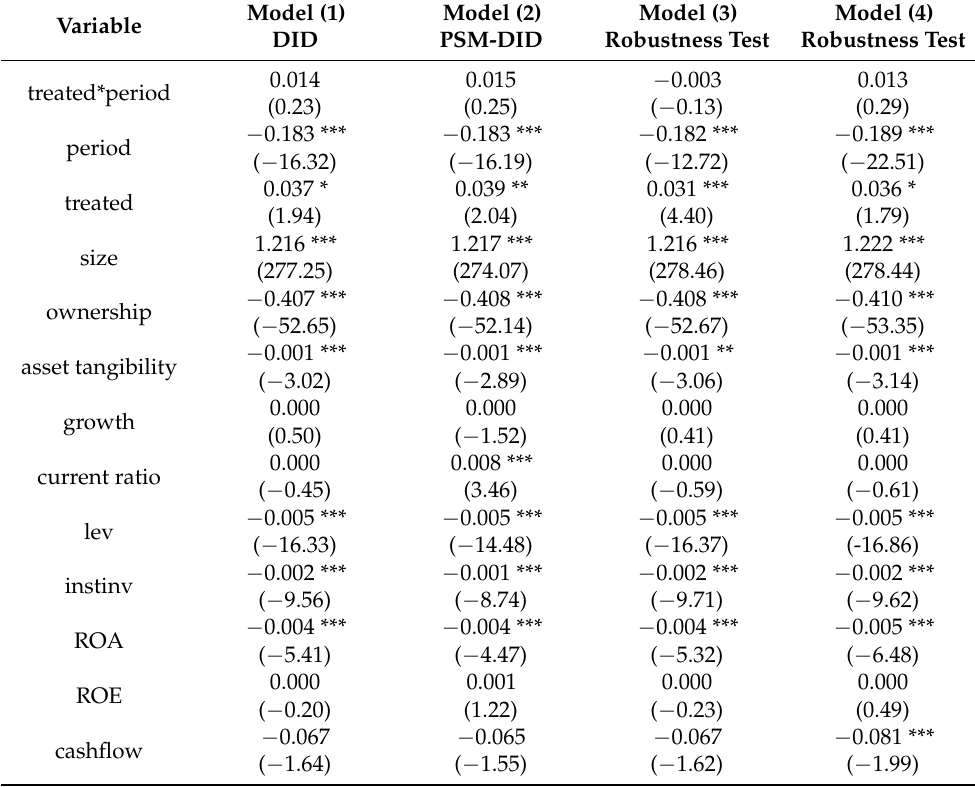
Table 3. Results and robustness